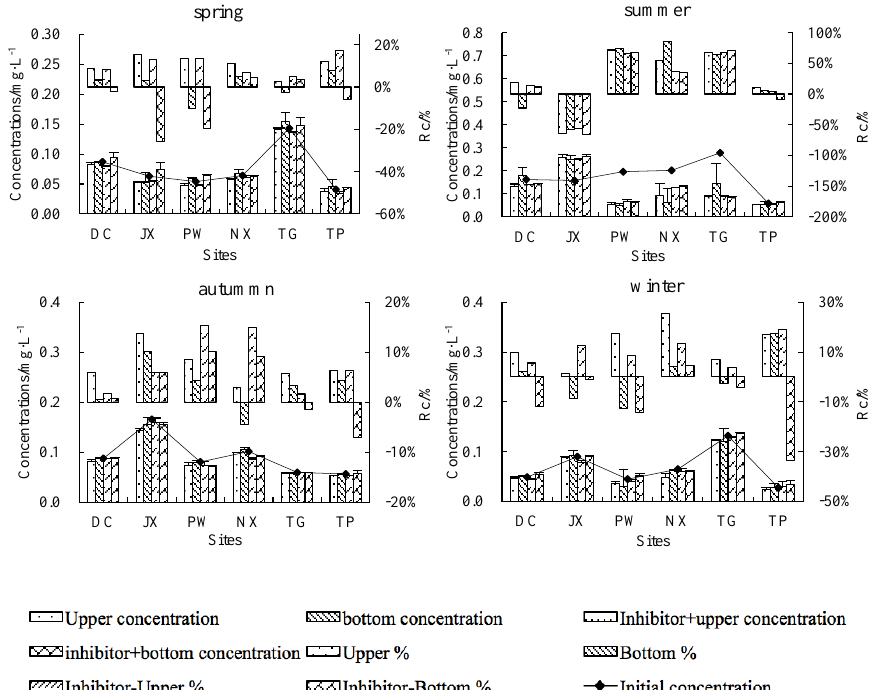
Figure 7. Initial NO 2 − -N concentrations (line), final upper- and bottom-layer NO 2 − -N concentrations (lower histogram) and percent change from initial NO 2 − -N concentrations (upper histogram). A negative percentage indicates an increase in concentrations and vice versa.